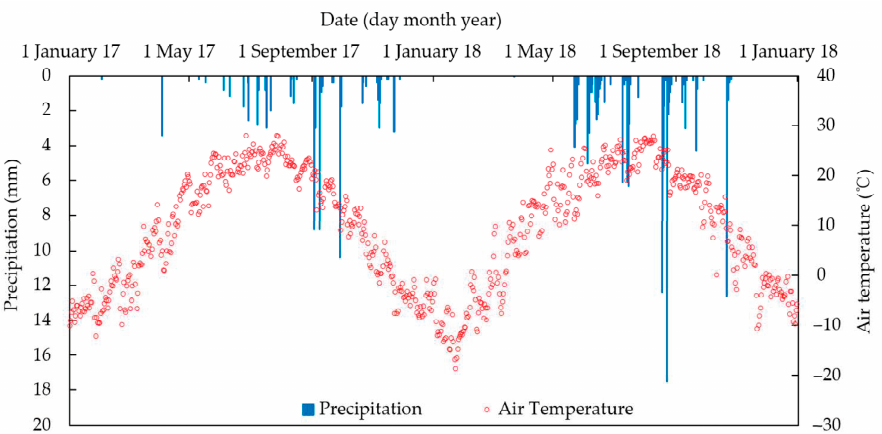
Figure 3. Air temperature and precipitation observed in Shahaoqu experiment station in 2017–2018.